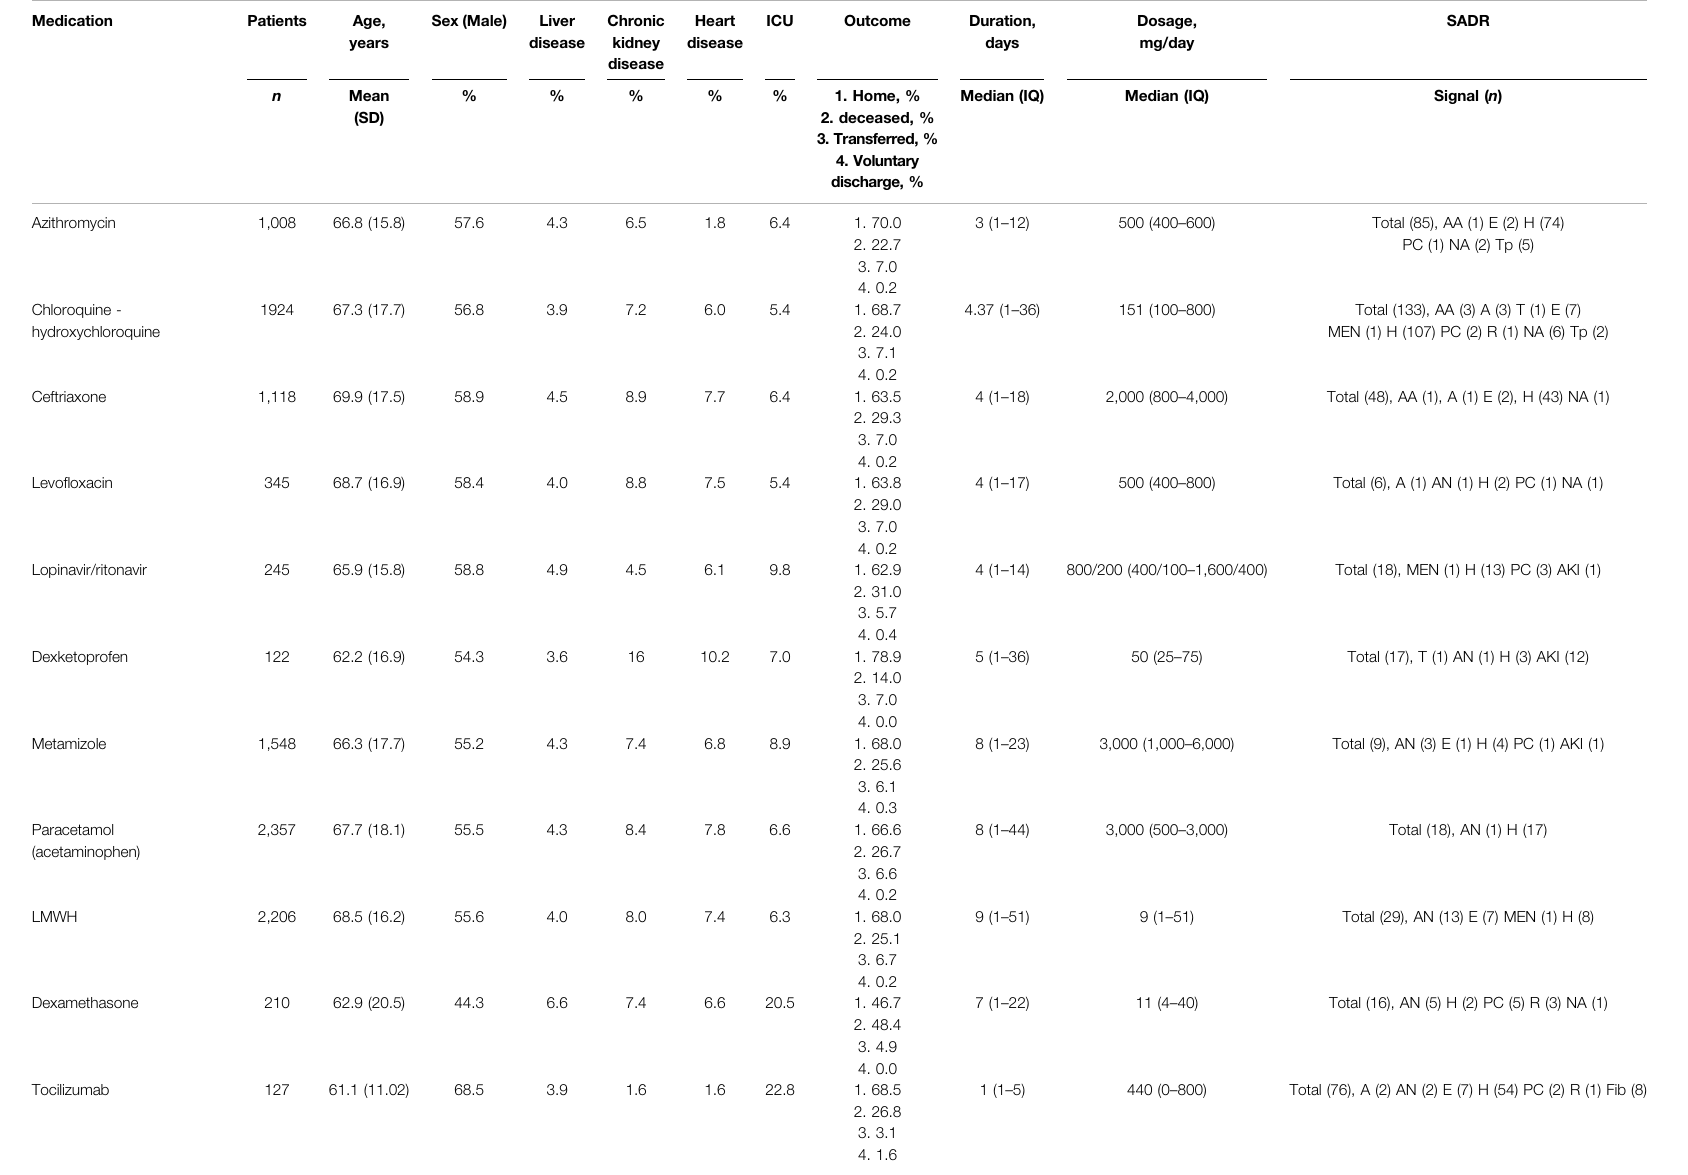
TABLE 5 | Medications, prescriptions, comorbidities, outcome, serious adverse drug reactions.